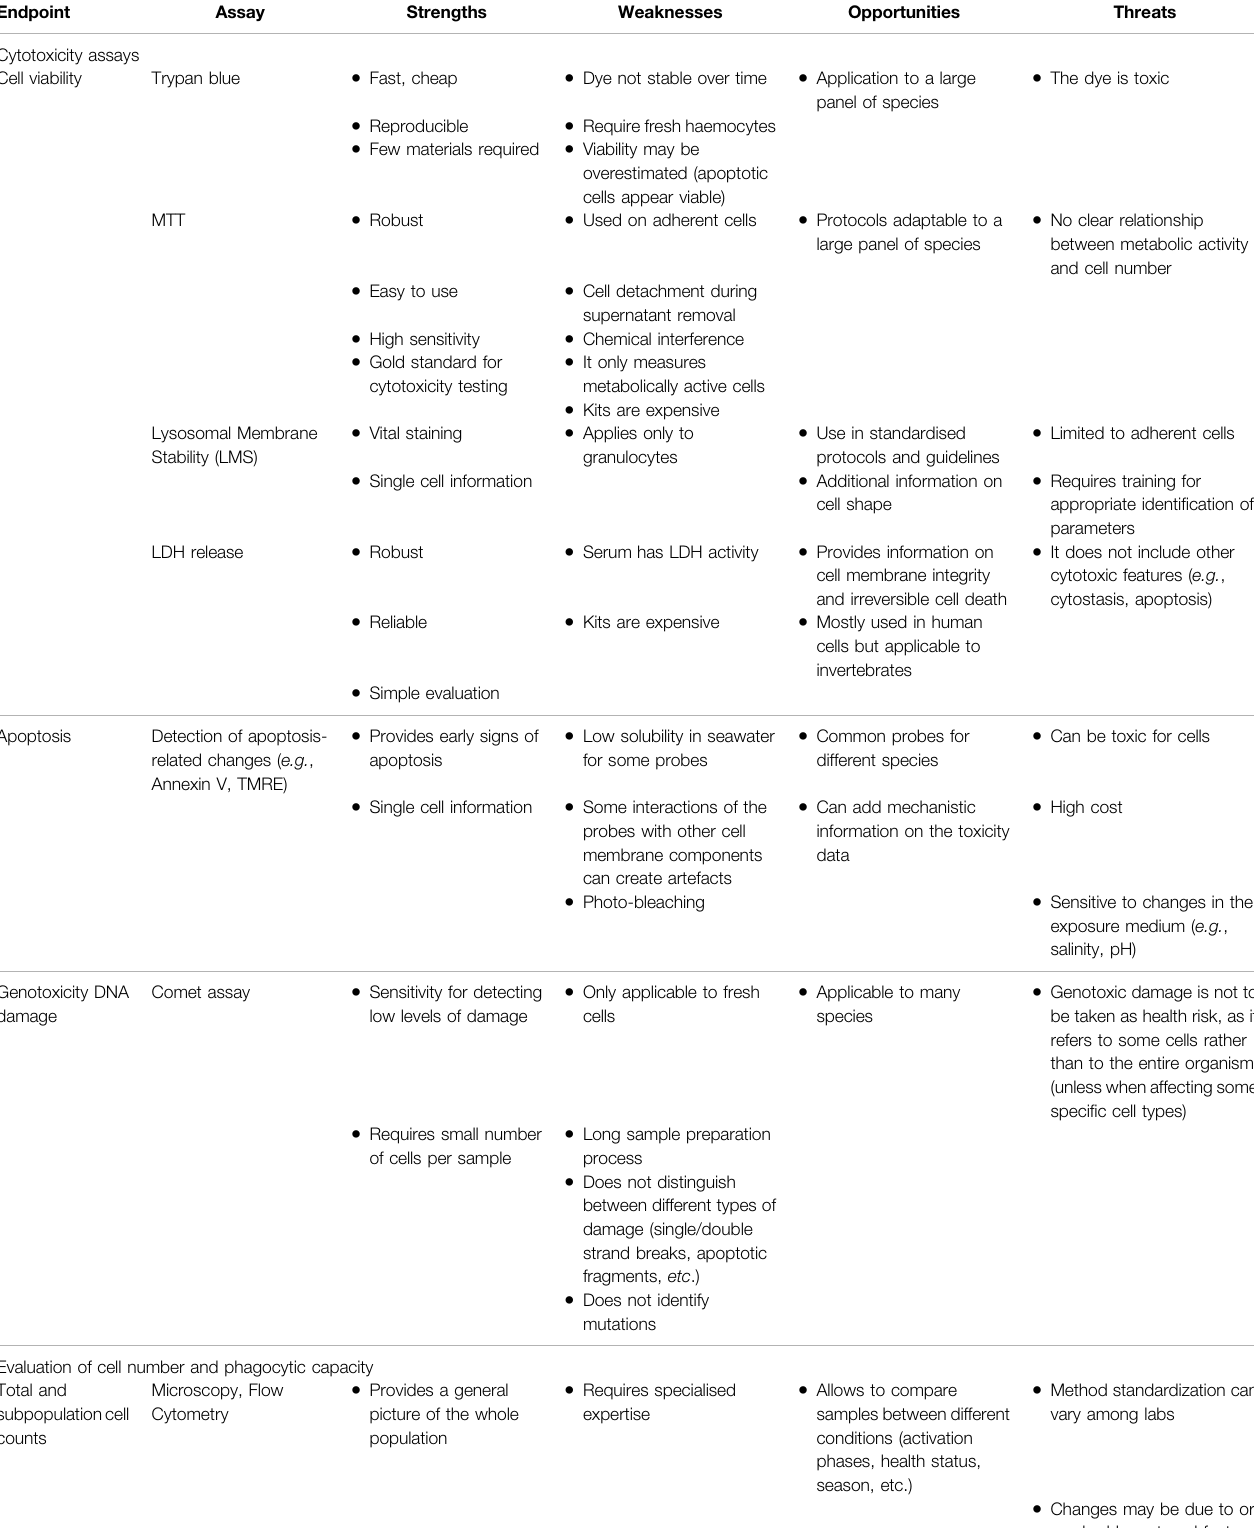
TABLE 4 | SWOT analysis of the cross-species assays/endpoints for immunotoxicity assessment. Endpoint Assay Strengths Weaknesses Opportunities Threats Cytotoxicity assays Cell viability Trypan